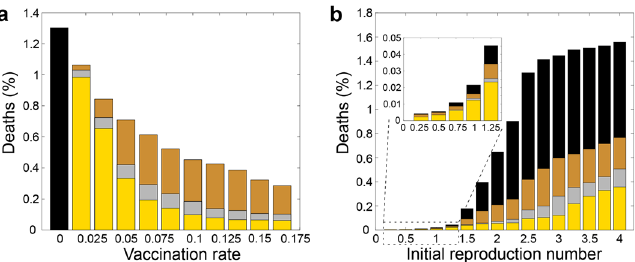
Figure 3. Fraction of deaths as a function of the vaccine production rate (left) and the initial basic reproduction number (right) for the demographic strategy (bronze), the infection-weighted strategy (silver) and the focusing strategy (gold). Results without vaccination (black) are shown for comparison. The results are based on the agent-based model; the statistical mean-field equations lead to very similar graphs. Parameters are shown in the key; remaining ones are as in Fig. 2.